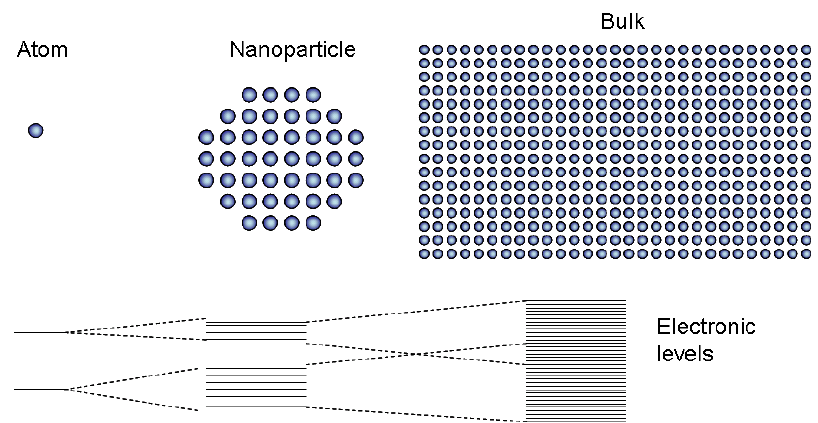
FIGURE 1. Evolution of electronic levels from a single atom to the bulk